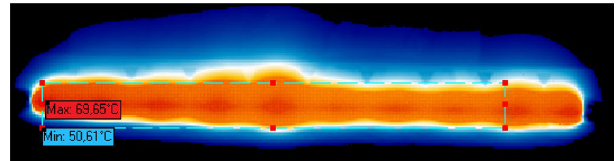
Figure 10. Infrared image of a printed micro heater during operation.